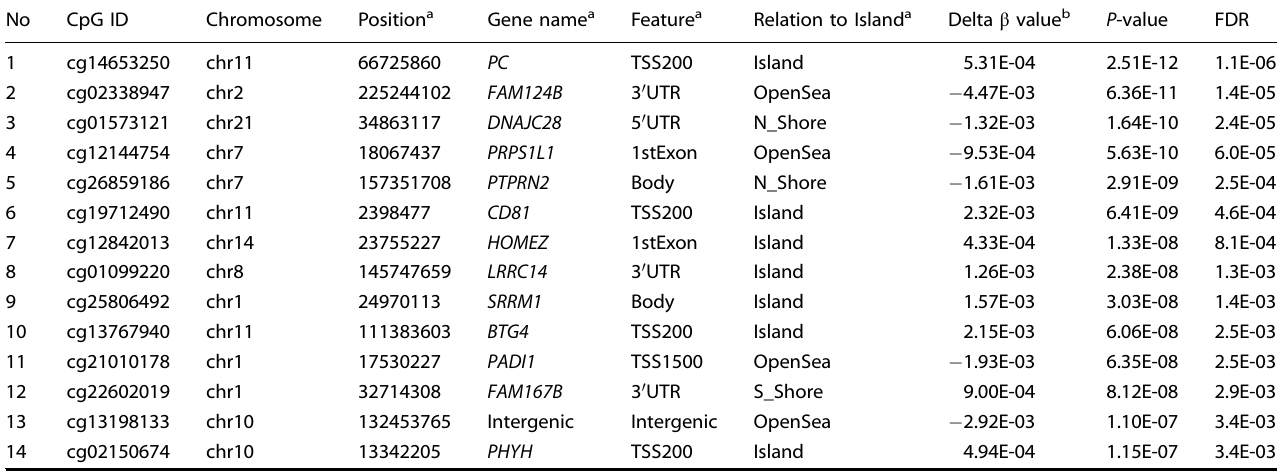
Table 2. List of differentially methylated positions associated with CRP among